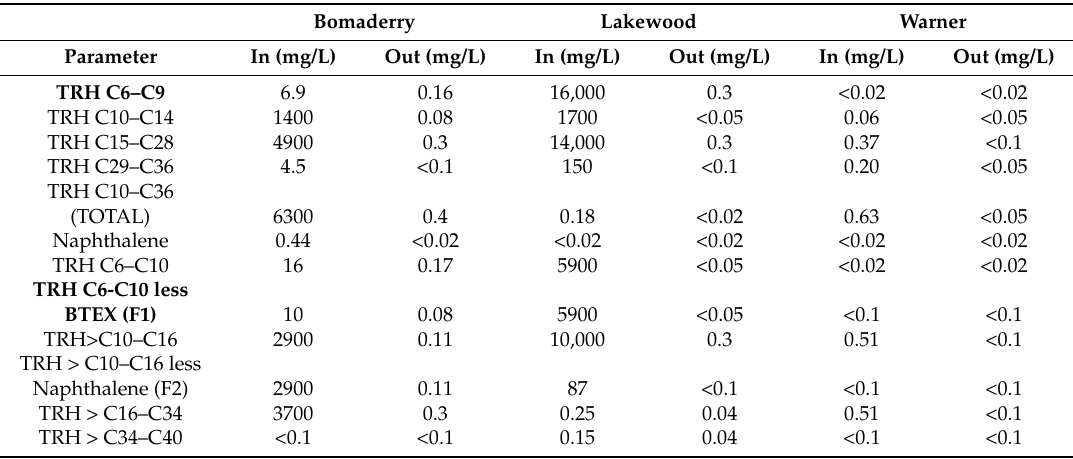
Table 3. Grab sample Water Quality Results.